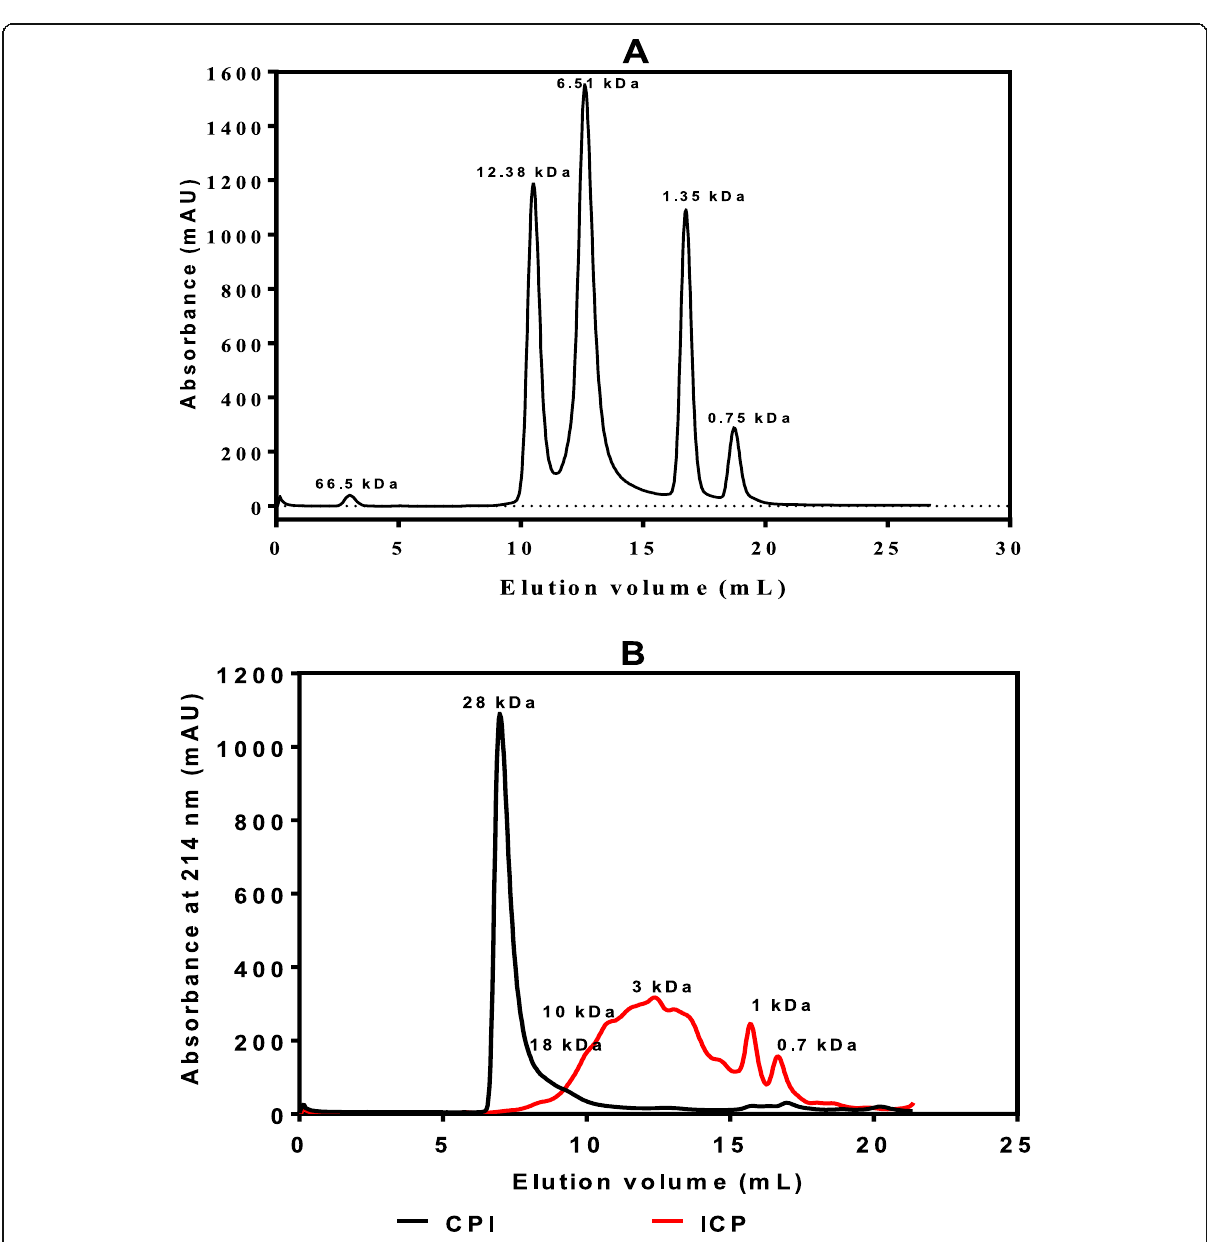
Fig. 3 a Standard proteins used to calibrate the gel-permeation column: bovine serum albumin (66.5 kDa), cytochrome c (12.38 kDa), aprotinin (6.51 kDa), vitamin B12 (1.35 kDa) and glycine (0.75 kDa). b Molecular weight distribution of cowpea protein isolate (CPI) and indigestible cowpea protein (ICP) from pepsin + pancreatin digestion of CPI pretreated with gelation (slow